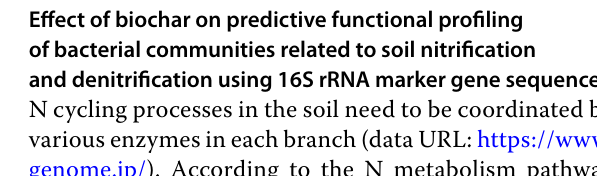
Values are mean plus standard deviation ( n 3), and data with different lowercase letters are significantly different at p < 0.05 according to Duncan’s multiple range = test. Treatments CK, BC1, BC2, BC3, and BC4 had biochar dosages of 0%, 0.5%, 1%, 2%, and 4%